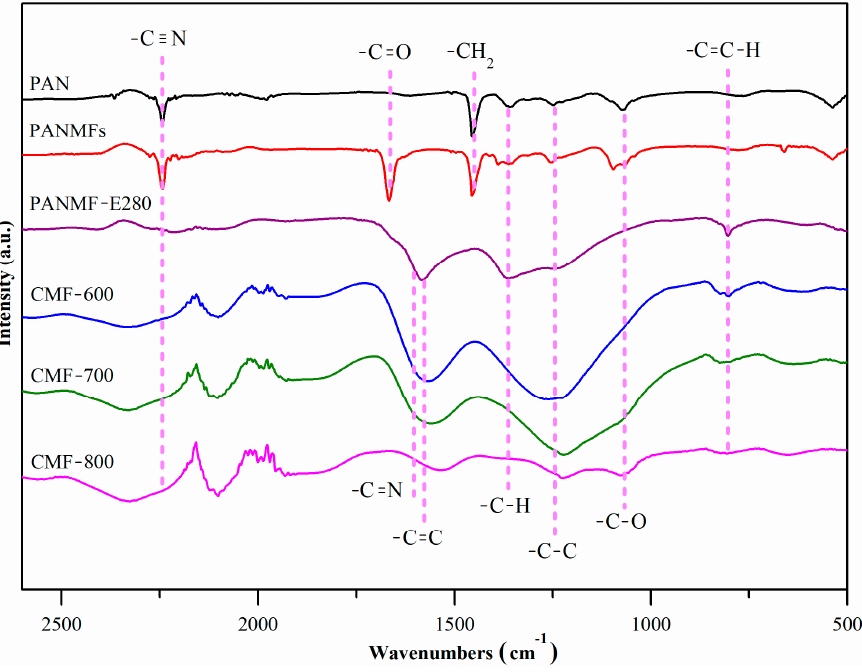
Figure 2. FTIR spectra of PAN, PANMFs and PANMFs stabilized and carbonized.